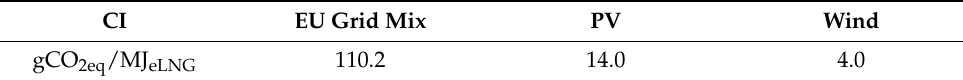
Table 4. Carbon intensity of